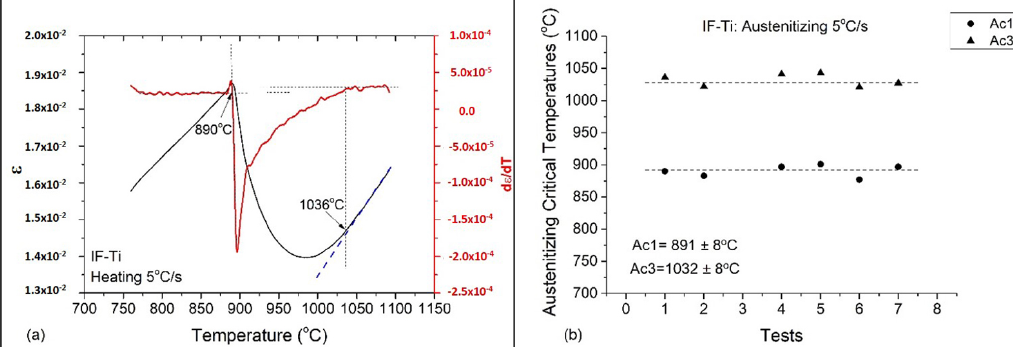
Figure 2. (a) Example of a dilatometric curve of IF-Ti steel continuous heated at 5 o C/s constant rate; (b) Ac experimentally determined for the IF-Ti